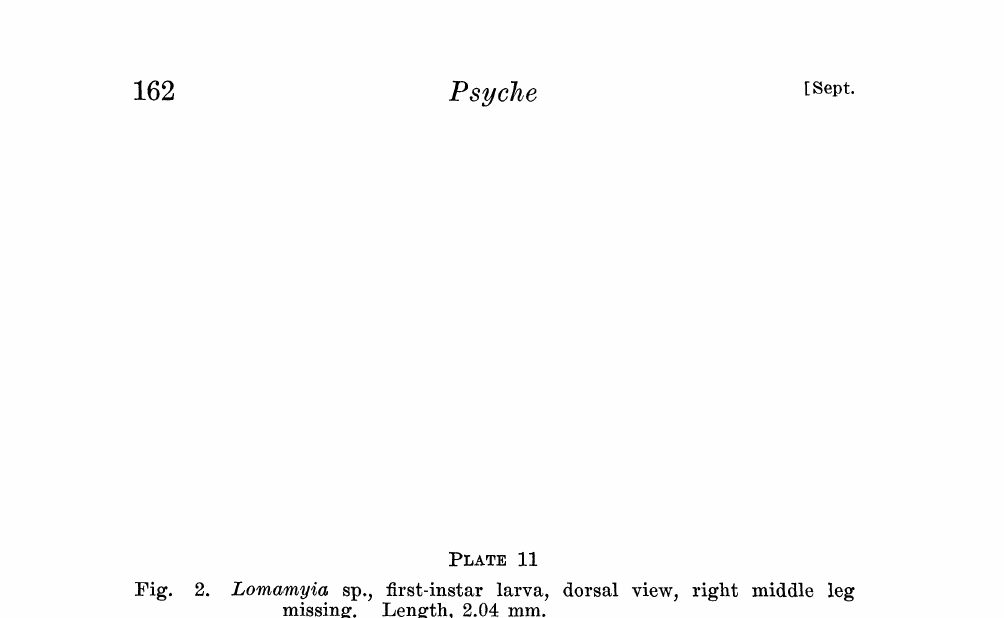
Fig. 2. Lomamyia sp., first-instar larva, dorsal view, right middle leg missing. Length, 2.04 mm. Fig. 3. Nallachius americanus, cocoon. Length, 3.26 ram. Fig. 4. Spermophorella disseminata Till., first-instar larva, dorsal view. Length, about 2.5 mm. (Adapted from Tillyard, Proc. Linn. Soc. N. S. Wales, vol. 41, pl. 18, fig. 32, 1916.) Fig. 5. Lomamyia sp., mature larva, dorsal view. Beltsville, Yld. Length, 9.36 mm. Fig. 6. Nallachius americanus, mature larva, dorsal view. College Park, Md. Length, 12